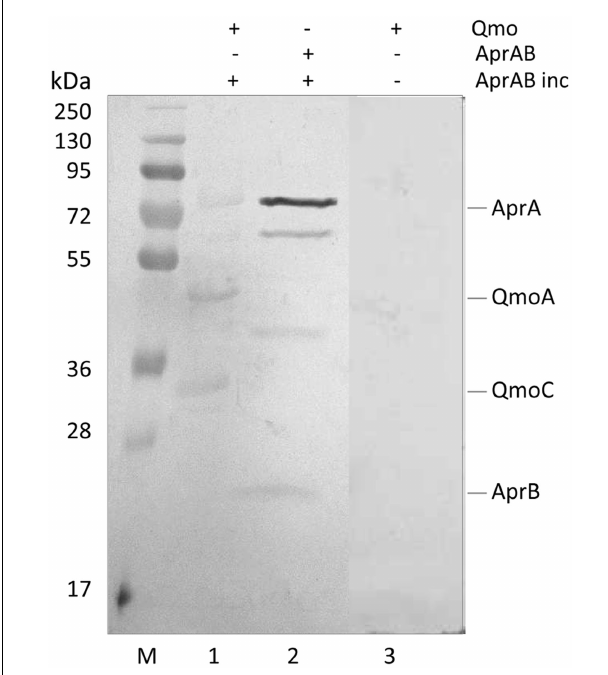
FIGURE 3 | Detection of interacting subunits by cross-linking Far-Western Blot withAnti-AprAB antibodies. From left to right: M – Pre-stained molecular mass markers; (1) QmoABC in PVDF membrane was incubated with AprAB (AprAB inc), cross-linked with EDC and detected; (2) positive control with AprAB in PVDF membrane; (3) negative control with QmoABC in PVDF membrane not incubated with AprAB.